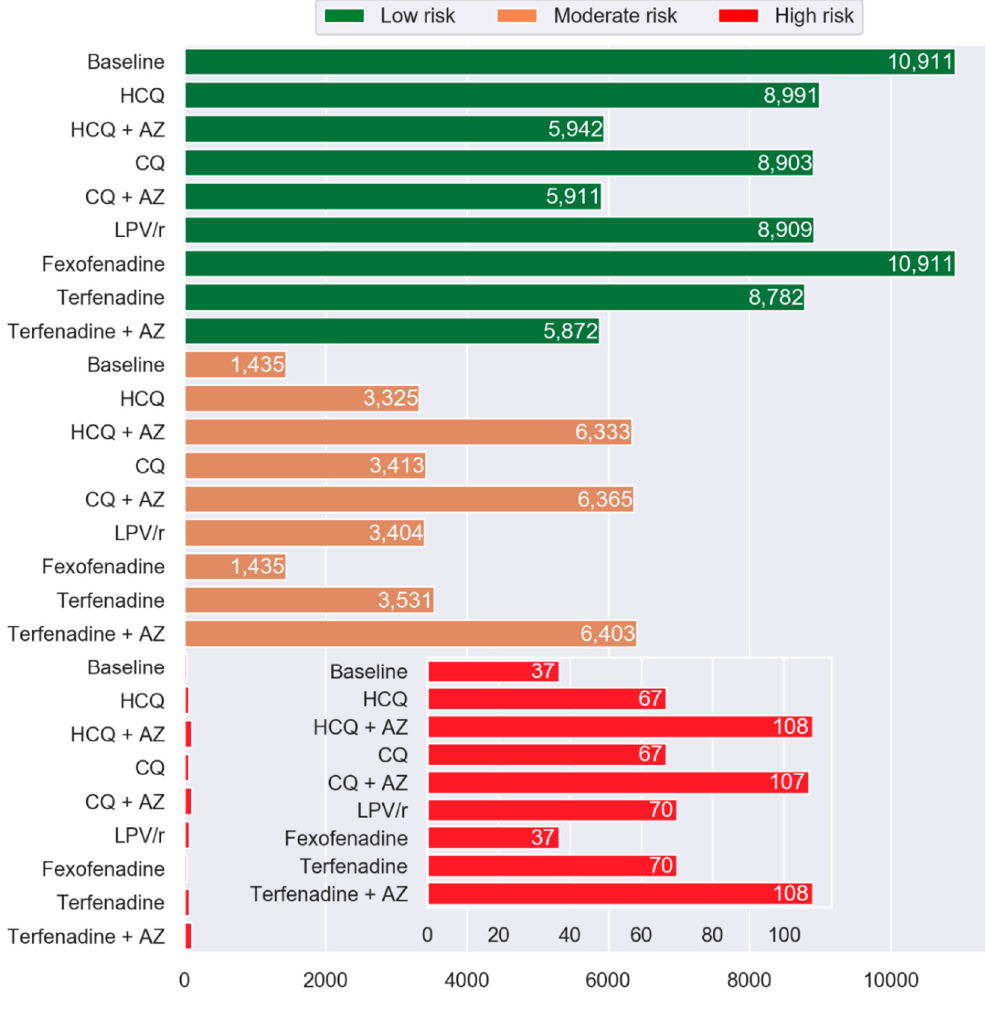
Figure 5. Histogram showing frequency of PACE patients in Low, Moderate, and High LQTS risk categories by drug compared to the baseline. The inset shows the High-risk categories. The green, orange, and red represent the Low-risk, Moderate-risk, and High-risk, respectively. Abbreviations: HCQ, hydroxychloroquine; AZ, azithromycin; CQ, chloroquine; and LPV/r, lopinavir + ritonavir.